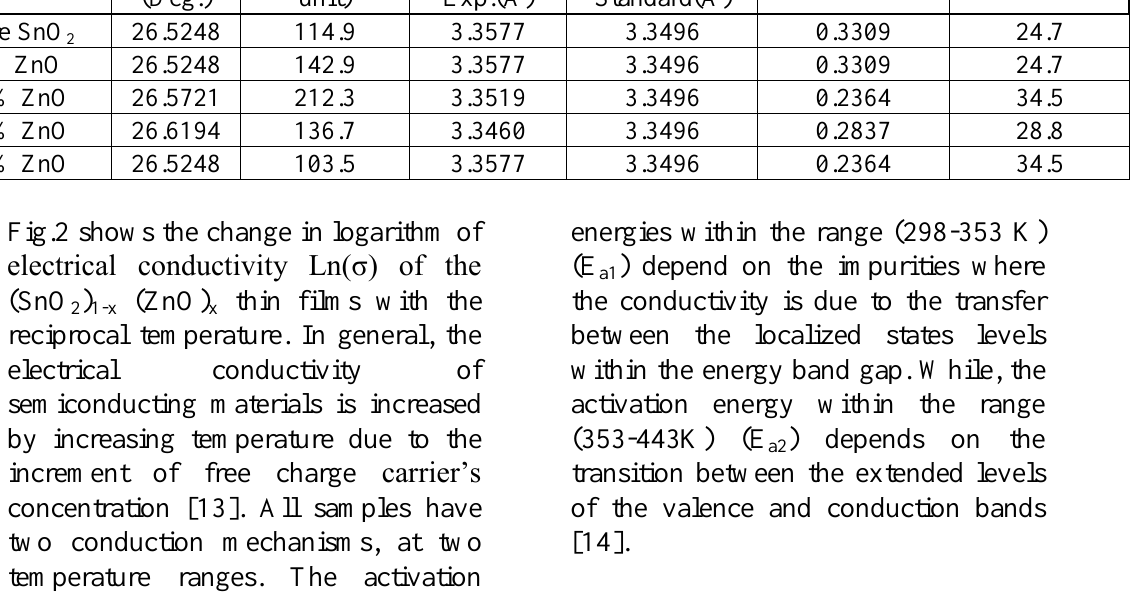
Table 1: 2θ, their intensity, experimental and standard d of SnO at different ZnO atomic ratio. 2